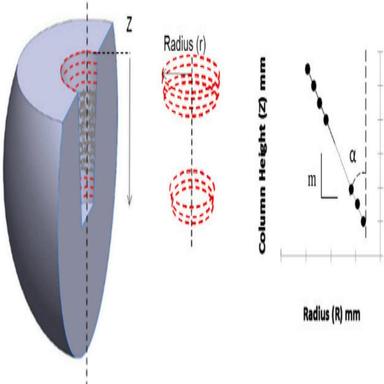
The radius and relative height on each roundness trace can be used to compute the taper angle.